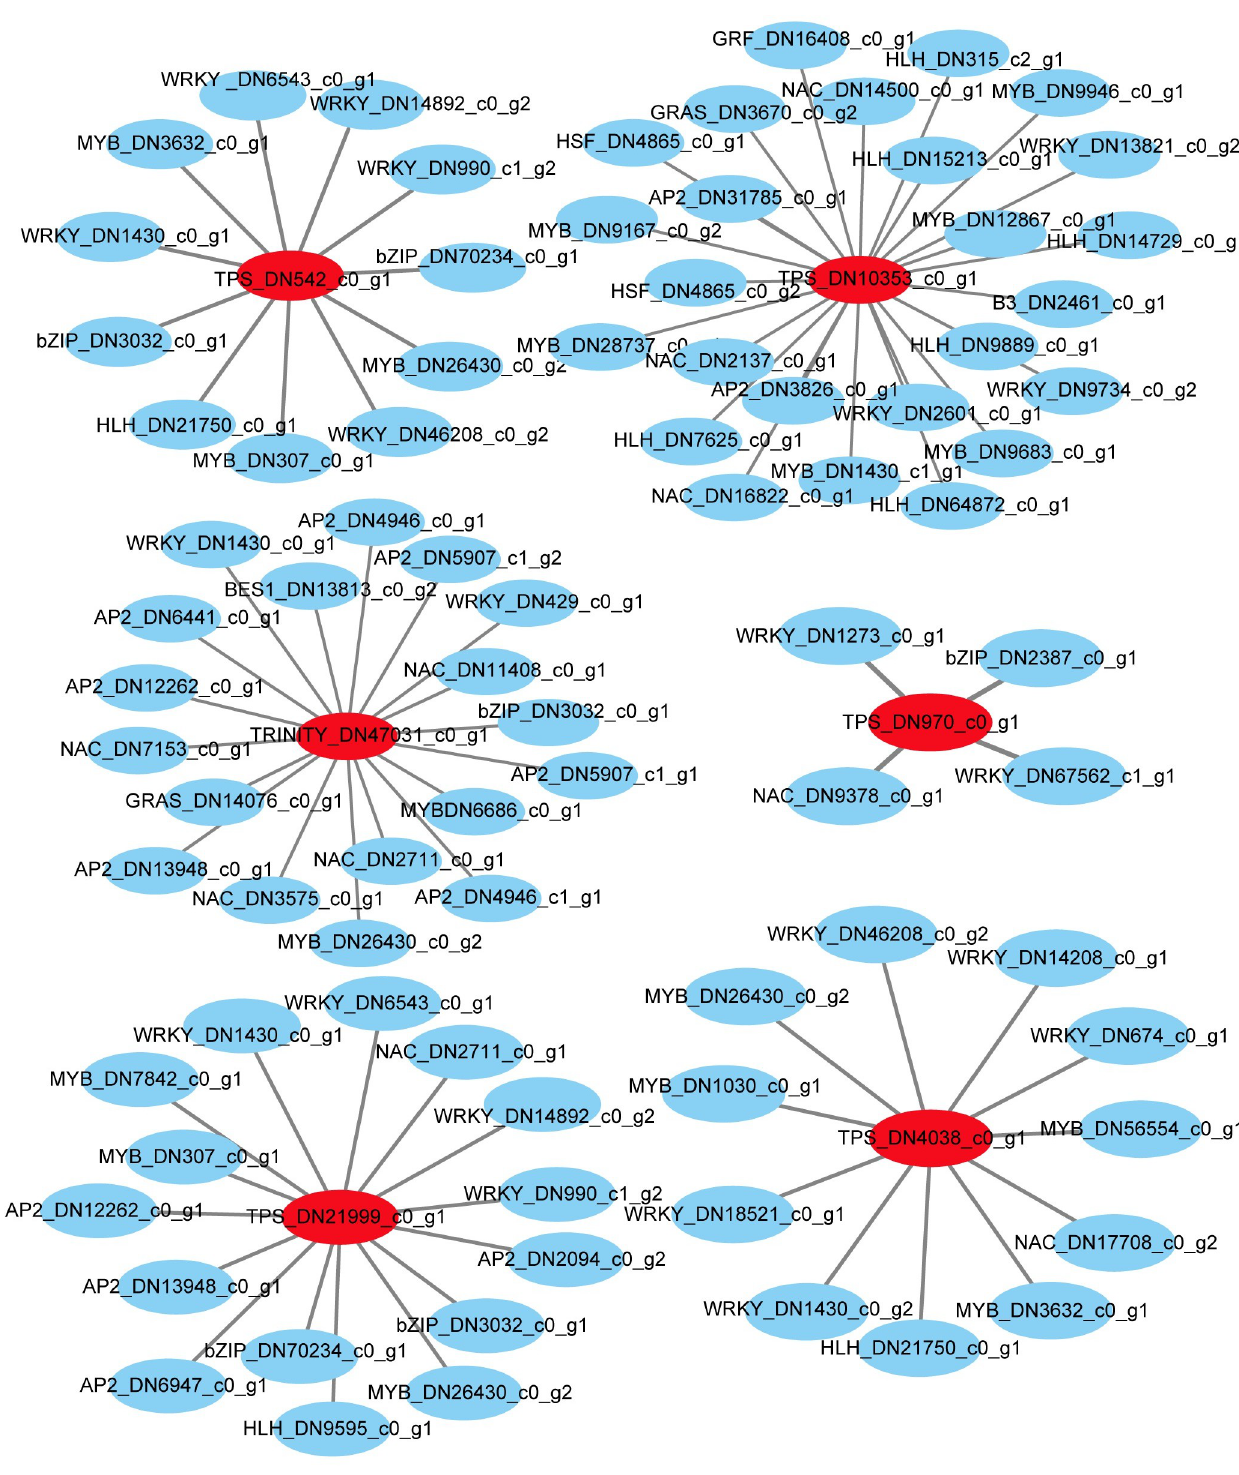
Fig 8. Co-expression network of differentially expressed CwTPSs and TF genes in C . wenyujin with MeJA-treatment. Each node represents a gene with its serial number and annotation information. Red nodes are CwTPSs , and blue nodes are TFs. Connecting lines represent co-expression relationships.